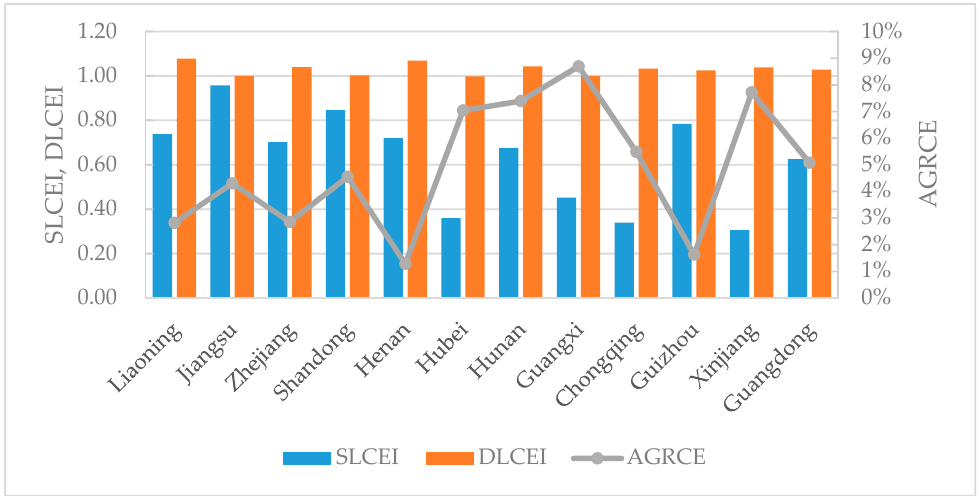
Figure 6. AGRCE, SLCEI, and DLCEI values for the pilot regions. AGRCE: average annual growth rate of the carbon emissions; SLCEI: static carbon emissions efficiency index; DLCEI: dynamic carbon emissions efficiency index